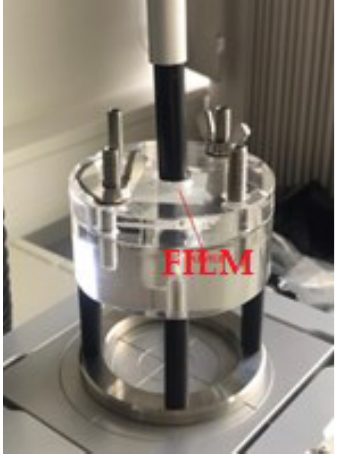
Figure 5. An apparatus to perform adhesion test for films.